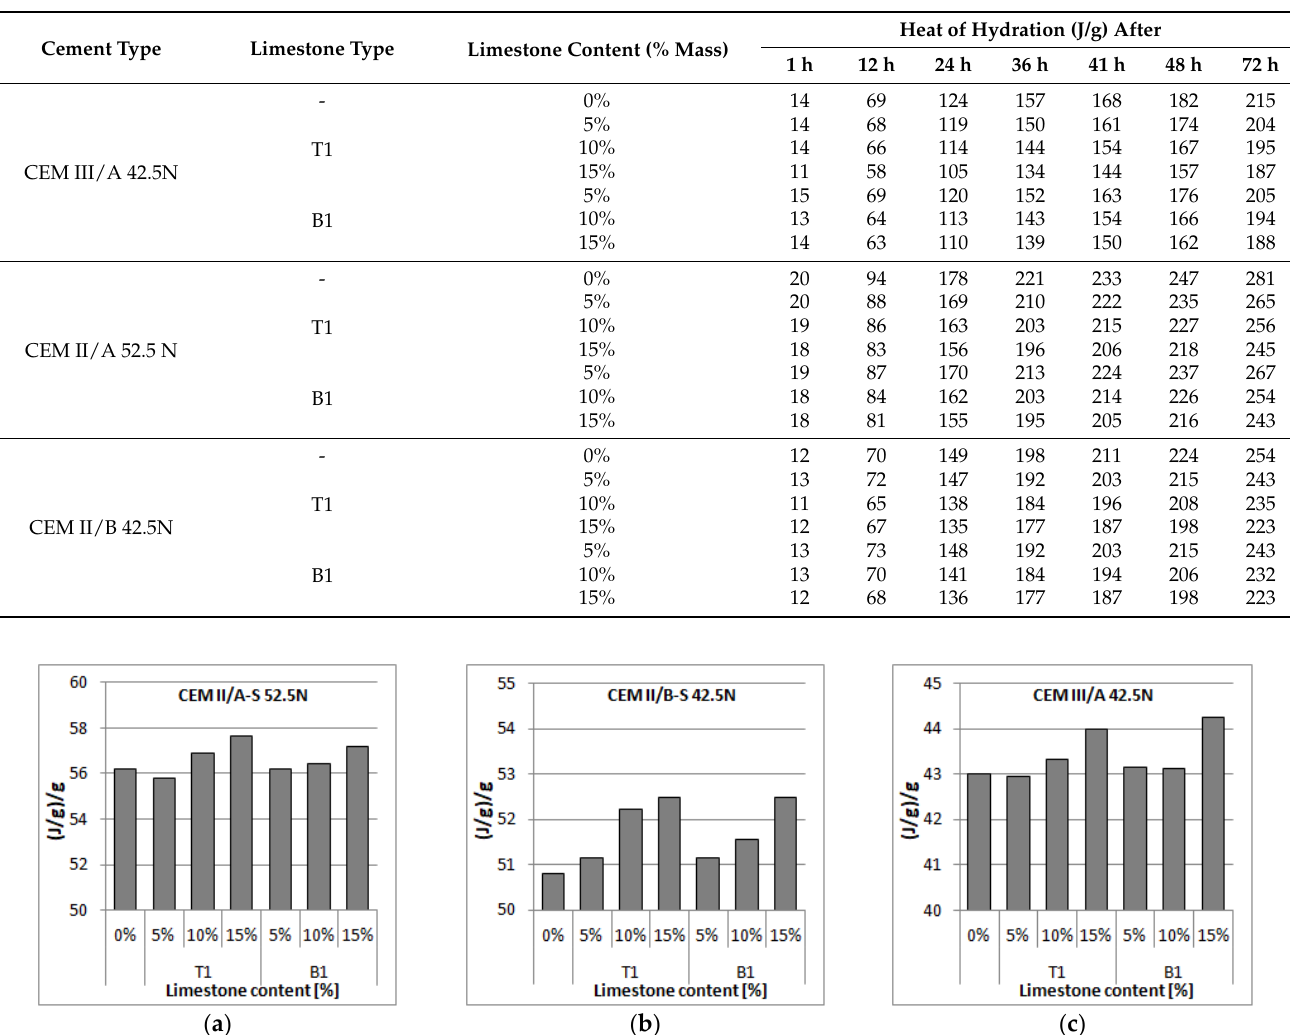
Table 6. Heat of hydration of slag-limestone cement with limestone T1 and B1.